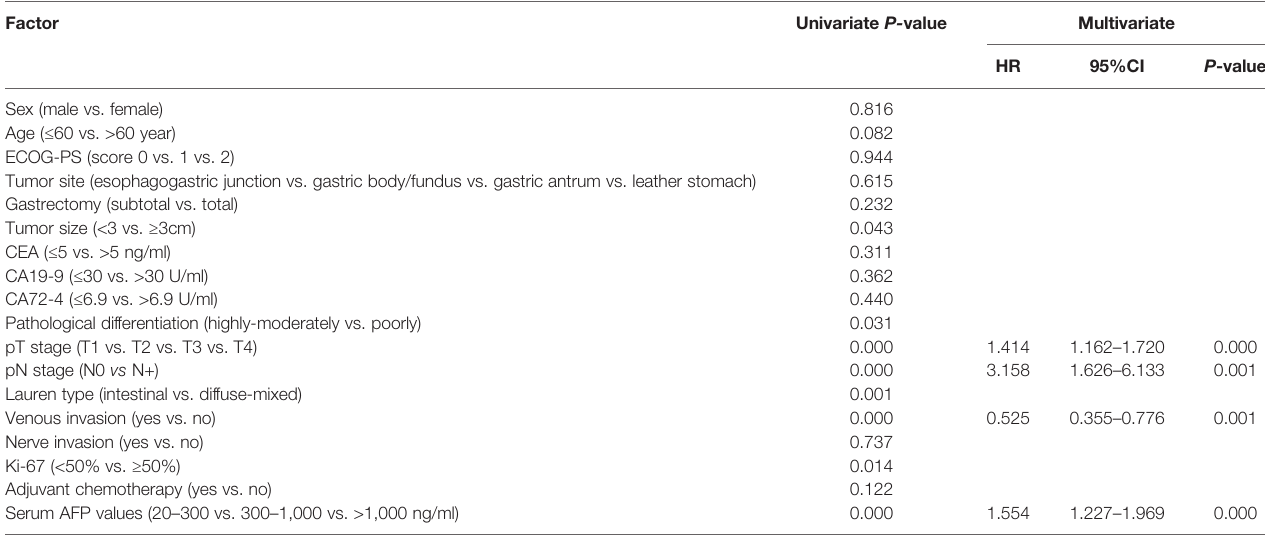
CI, con fi dence interval; HR, hazard